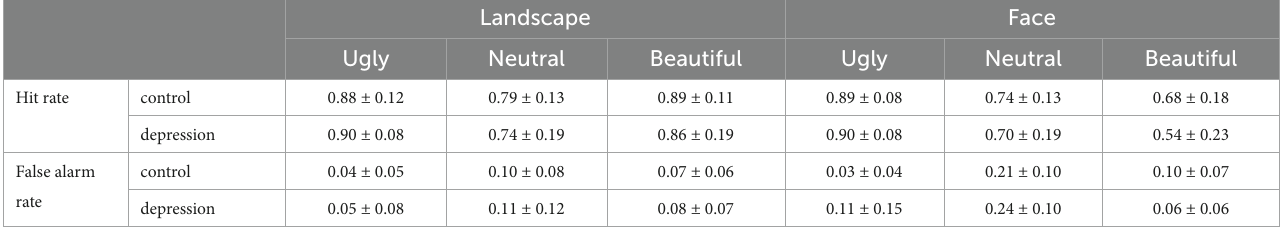
TABLE 2 The hit and false alarm rate under different respond of participants (mean ± SD). Landscape Face Ugly Neutral Beautiful Ugly Neutral